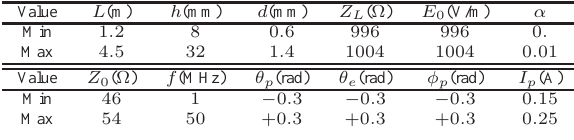
Table 3: Initial sets of parameters for the stochastic study.